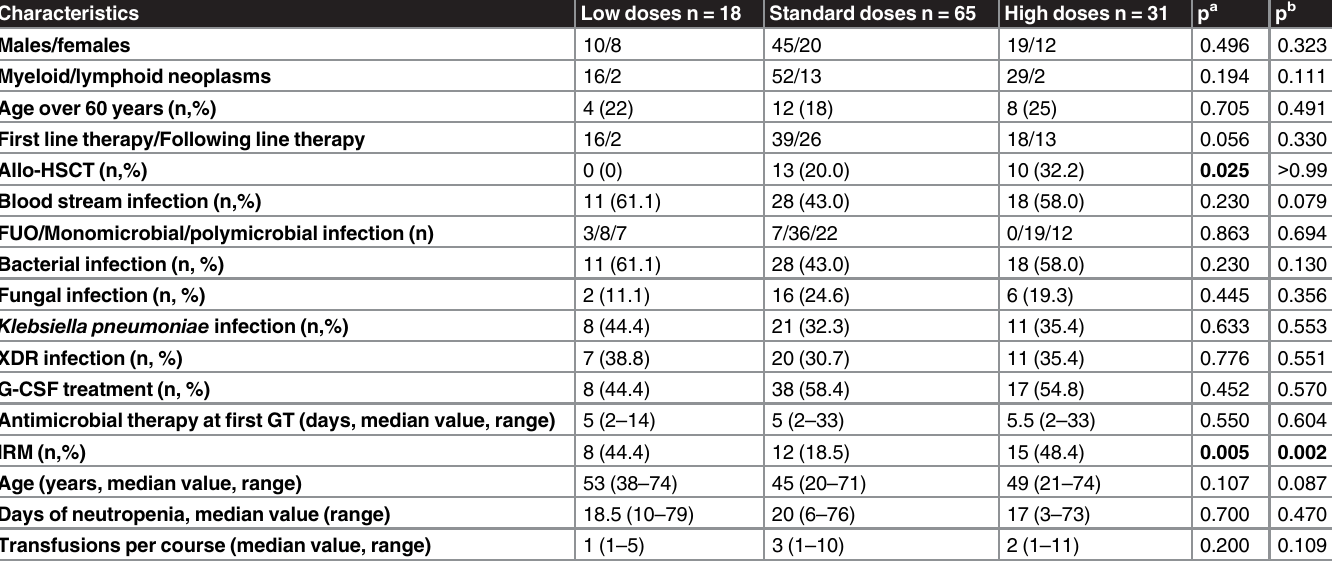
Table 4. Characteristics of patients grouped according to median PMN